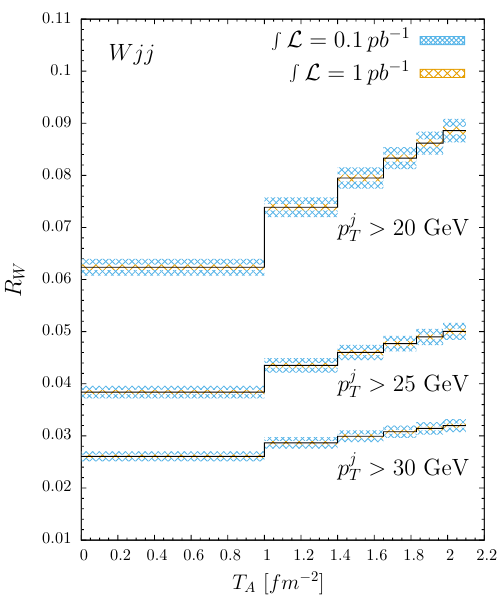
Fig. 5 The ratio R W as a function of T for W jj integrated in bins of T A for two values of the integrated luminosity and different cuts on jet transverse momenta